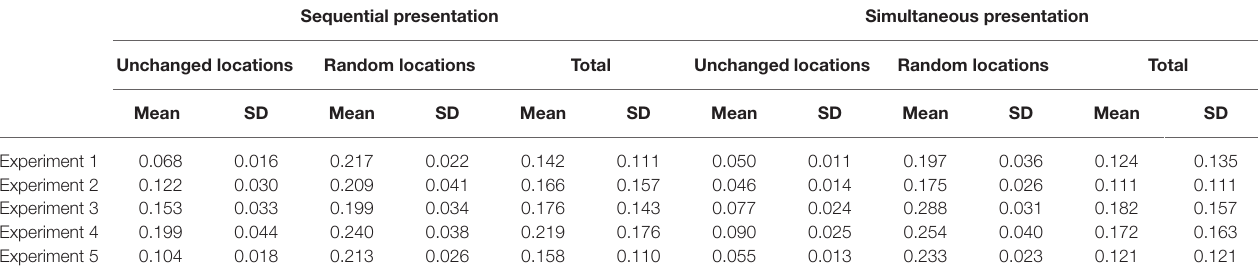
TABLE 3 | False alarms in all experimental conditions in the five